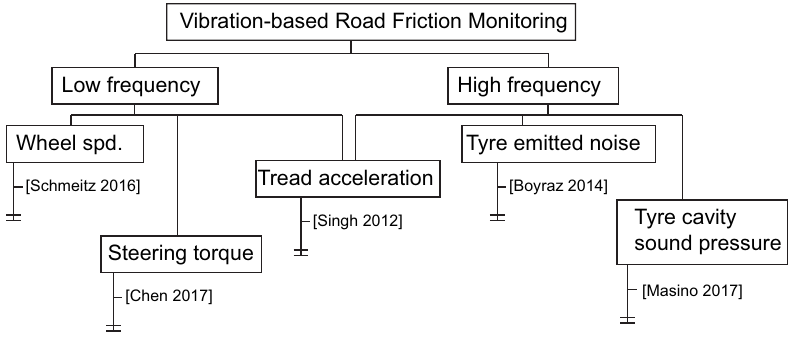
Figure 21. Classification followed on the discussion of vibration-based road friction monitoring